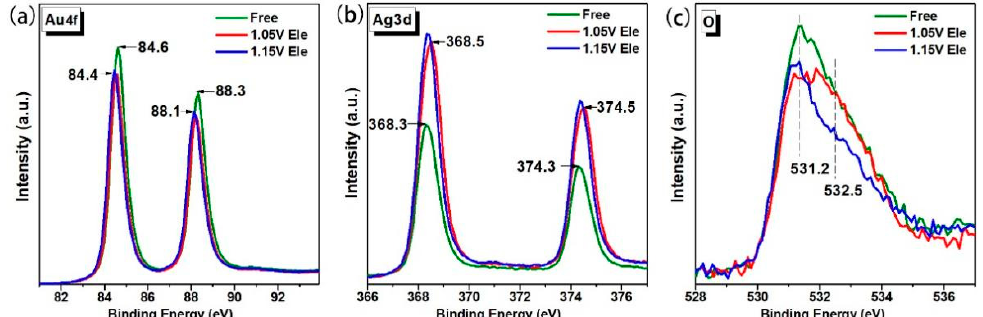
Figure 4. XPS spectra of selected NPG films prepared with different conditions. Binding energy of ( a ) Au 4f core levels, ( b ) Ag 3d core levels, and ( c ) O 1s level.